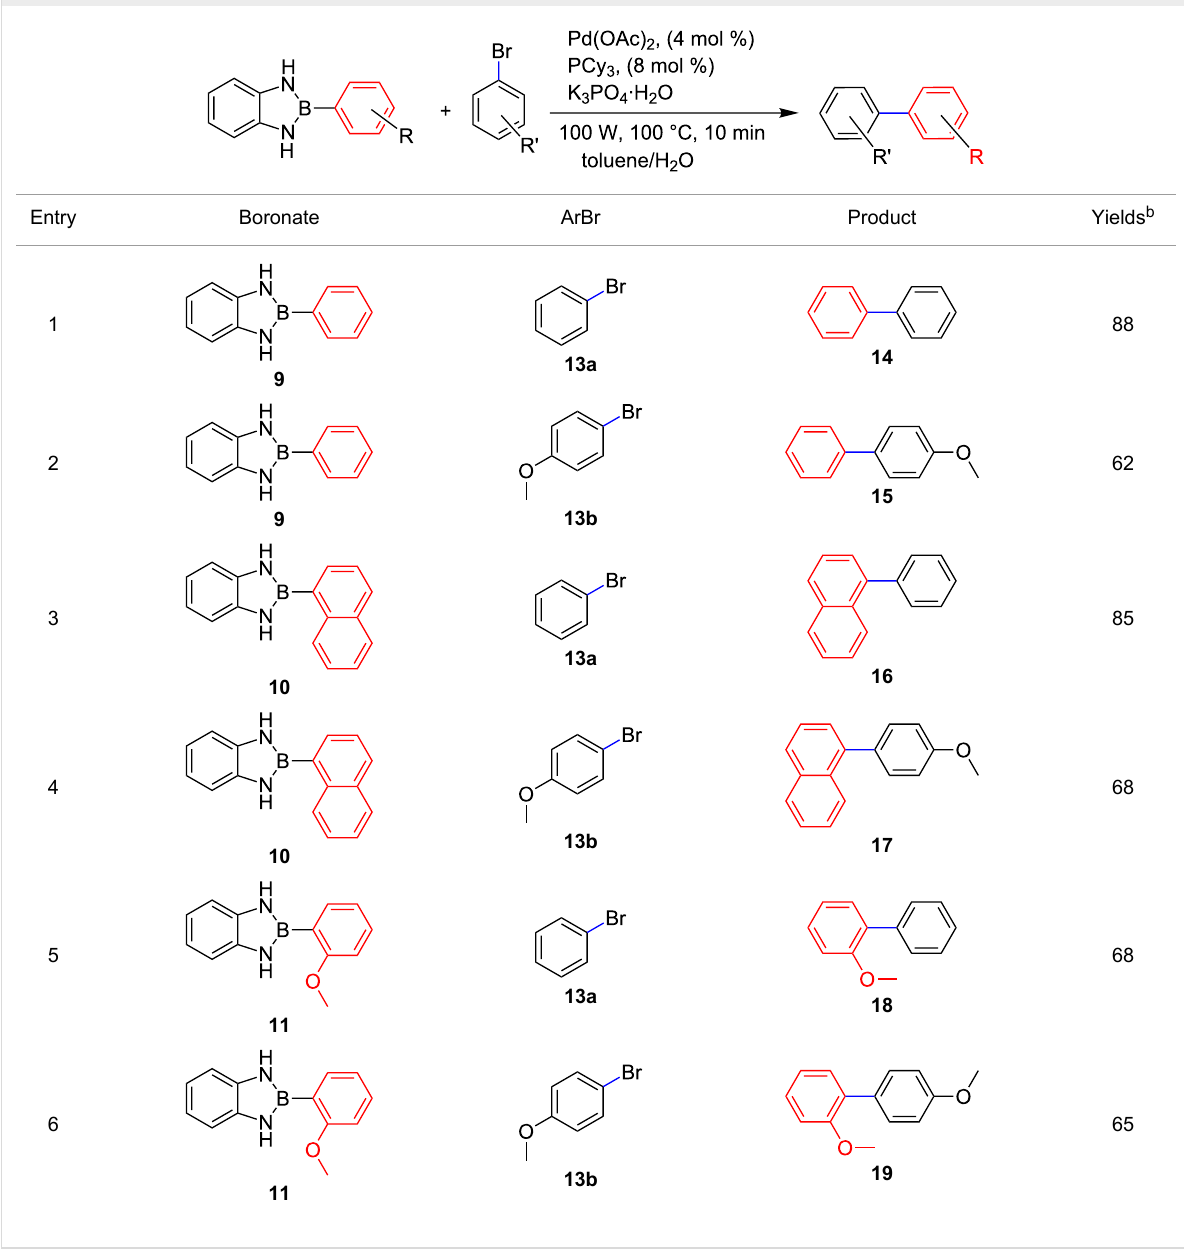
Table 2: Palladium-catalysed cross-coupling of boronate 9 – 12 with bromobenzene and 4-bromoanisole. a